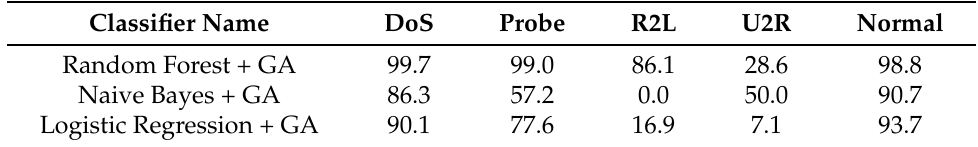
Table 2. Average detection rate of different proposed